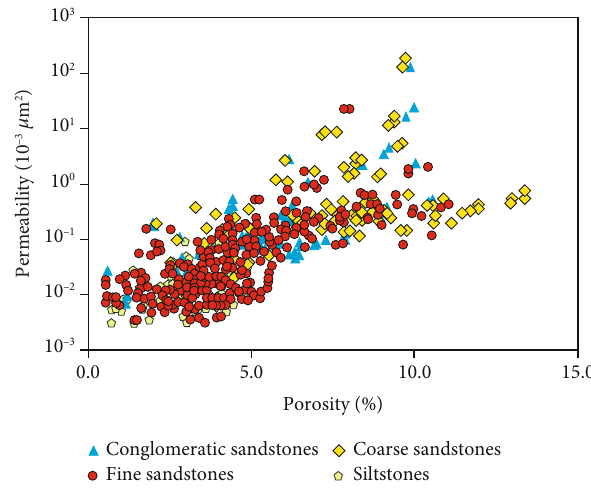
Figure 7: Relationship between porosity and permeability of di ff erent sandstone